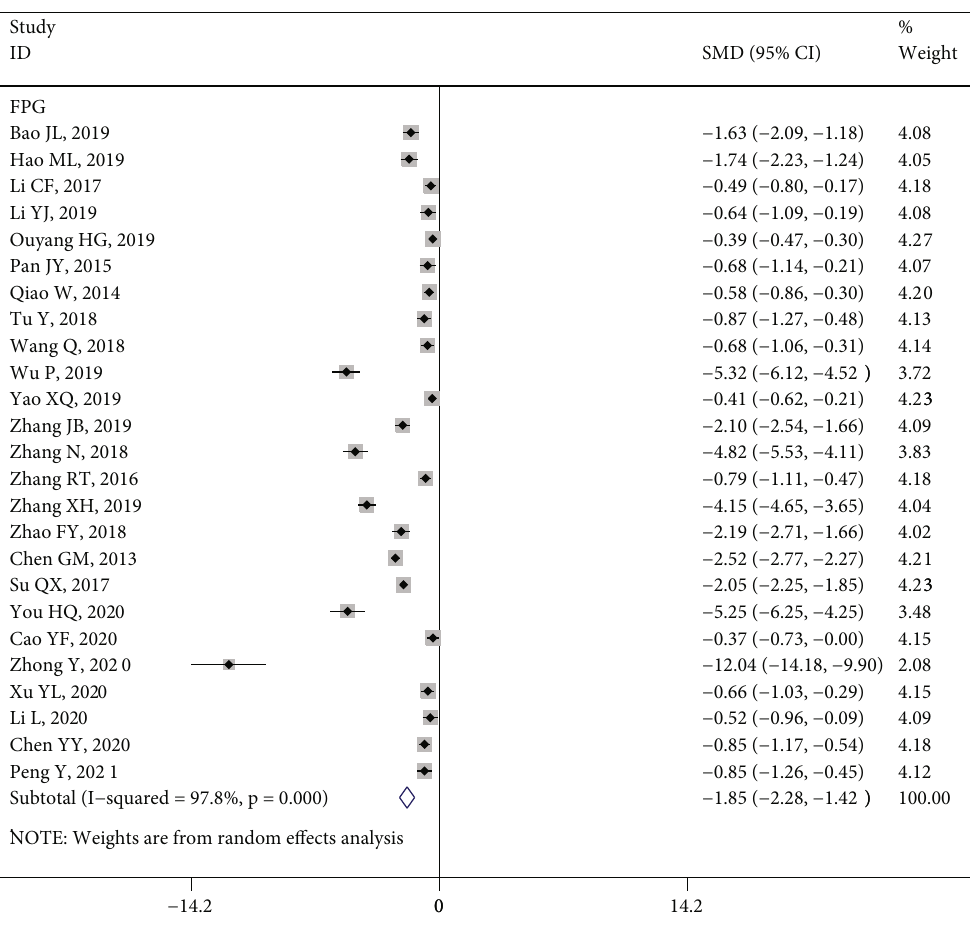
Figure 2: Forest plot of the e ff ect of health literacy intervention on